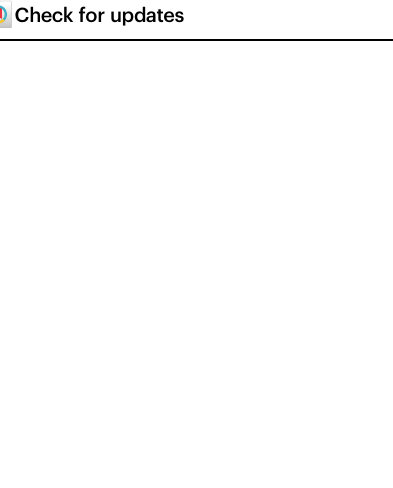
Table 1. The M − N 4 structures, especially Ni − N- and Fe − N-based